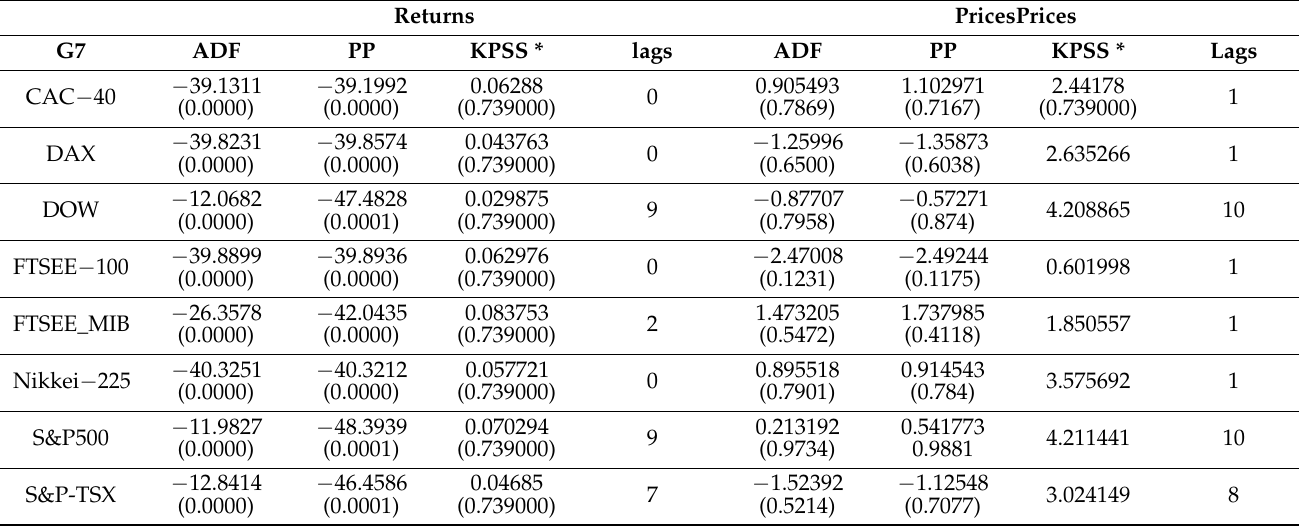
Table 5. G7 Unit Root Testing.